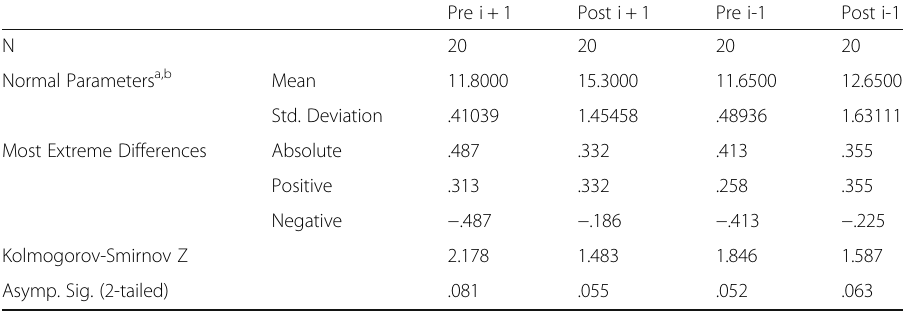
Table 1 One-Sample Kolmogorov-Smirnov Test (Groups ’ Pre and Post-tests) Pre i + 1 Post i + 1 Pre i-1 Post i-1 N 20 20 20 20 Normal Parameters a,b Mean 11.8000 Most Extreme Differences Absolute .487 Positive Negative − .487 Kolmogorov-Smirnov Z Asymp. Sig. (2-tailed)